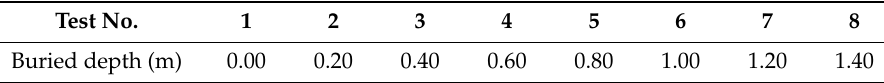
Table 3. Buried-depth status of the buried metal pile (full length 2.00 m).